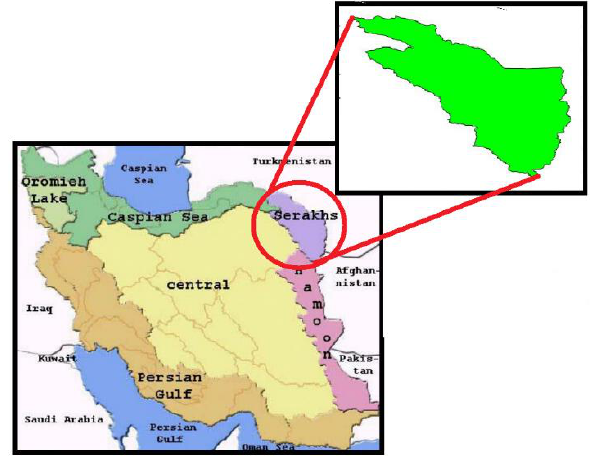
Figure 1. Location of Sarakhs